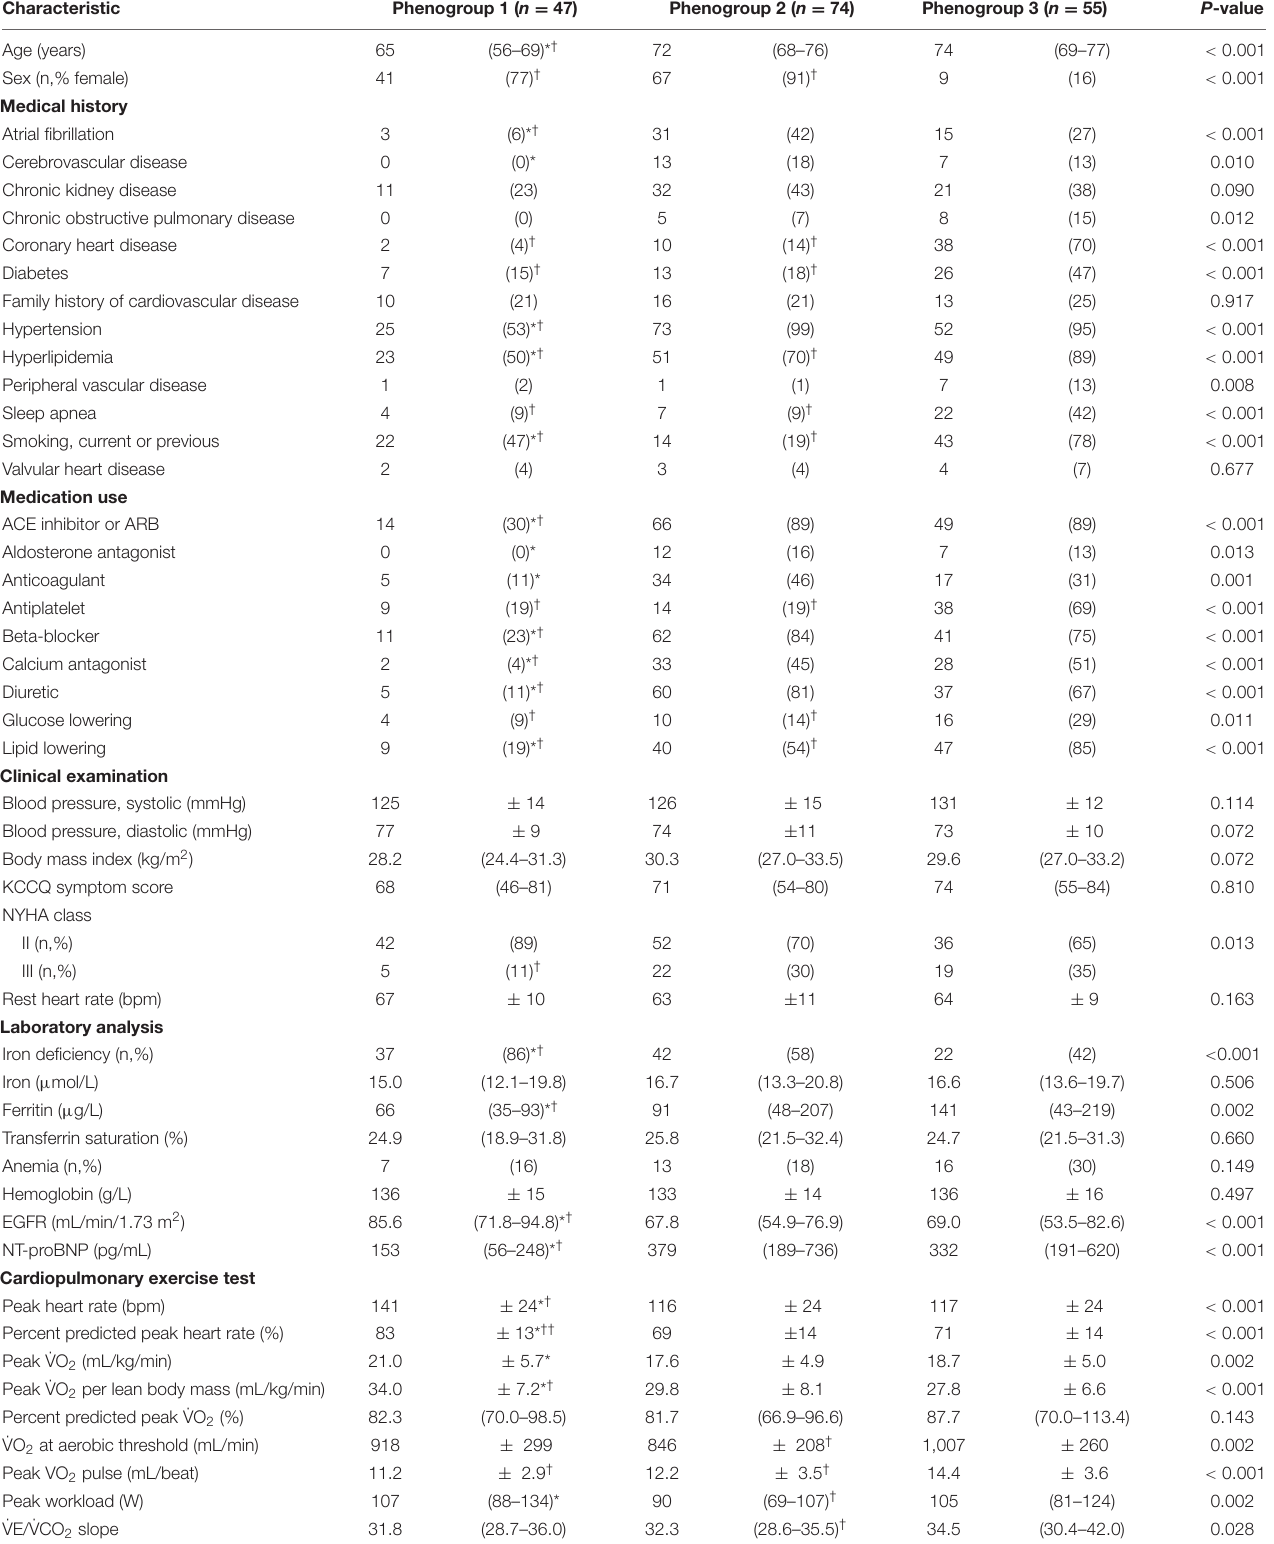
TABLE 3 | Characteristics of the study population, stratified according to